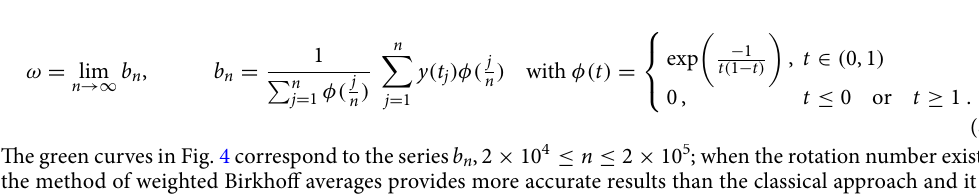
Figure 5. Frequency-based maps for the dynamic model (1), where ε = 0.02 . The colors for ( b ) and ( c ) are coded as follows: yellow—chaos, magenta—rotational motions, blue—librational